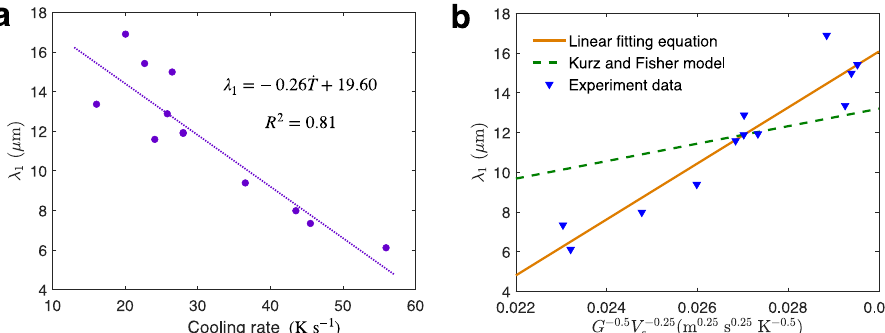
Fig. 5 Analysis of the primary dendrite arm spacing. a Primary dendrite arm spacing vs cooling rate. The dotted line is the linear fi t, ¼ (cid:2) 0 : 26 _ T þ 19 : 60 , where λ μ m) and _ T is the cooling rate (K s − 1 ). The R 2 error for the fi t is 0.81. Detail λ 1 1 is the primary dendrite arm spacing ( values and locations of samples are tabulated in Supplementary Table 7. b Comparison of measured primary dendrite arm spacing with in Eq. (4), while the dashed line is the analytical model of Kurz analytical models. The solid line is the best fi t to a model linear in G (cid:2) 0 : 5 V (cid:2) 0 : 25 s and Fisher in Eq. (3). The R 2 error for the linear fi tting equation is 0.90. The R 2 error for the Kurz and Fisher model is